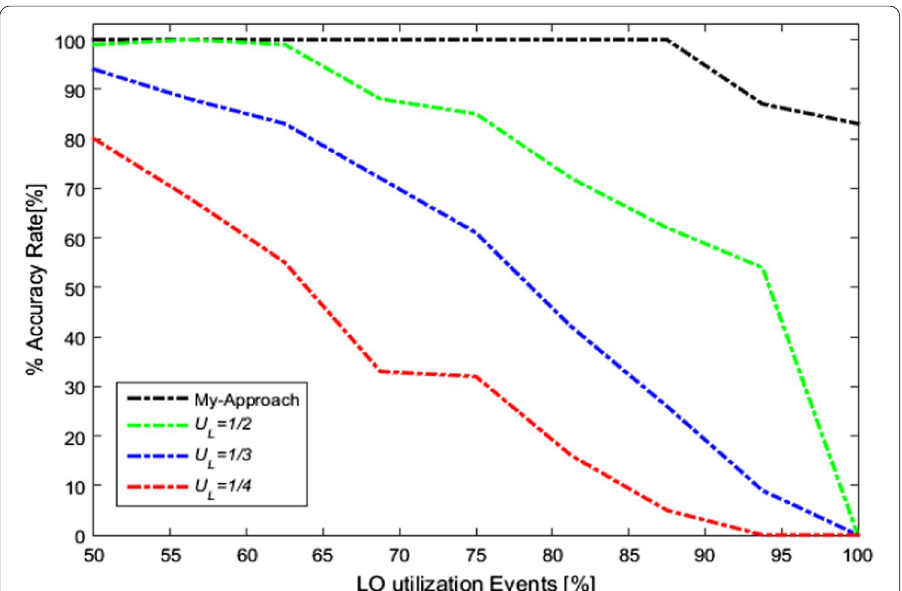
Fig. 4 Comparison of patient health control accuracy of the proposed method using 8 sensors with that of other